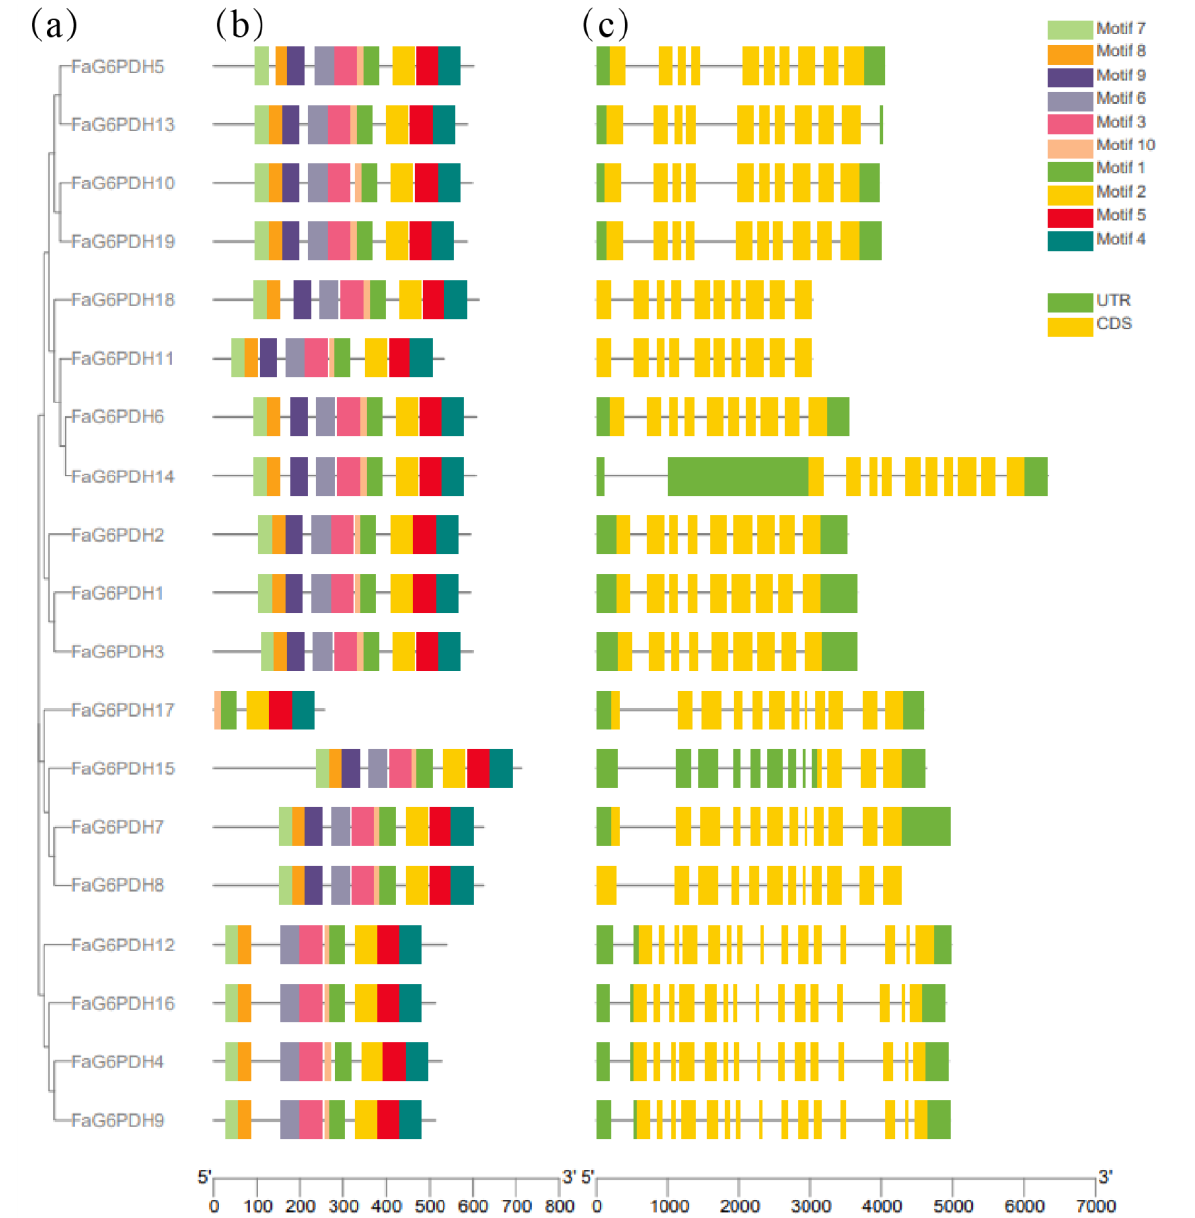
Figure 1. Gene structure and motif composition of FaG6PDH gene family. ( a ) Subgroup classification; ( b ) Conserved motif analysis; ( c ) Gene structural